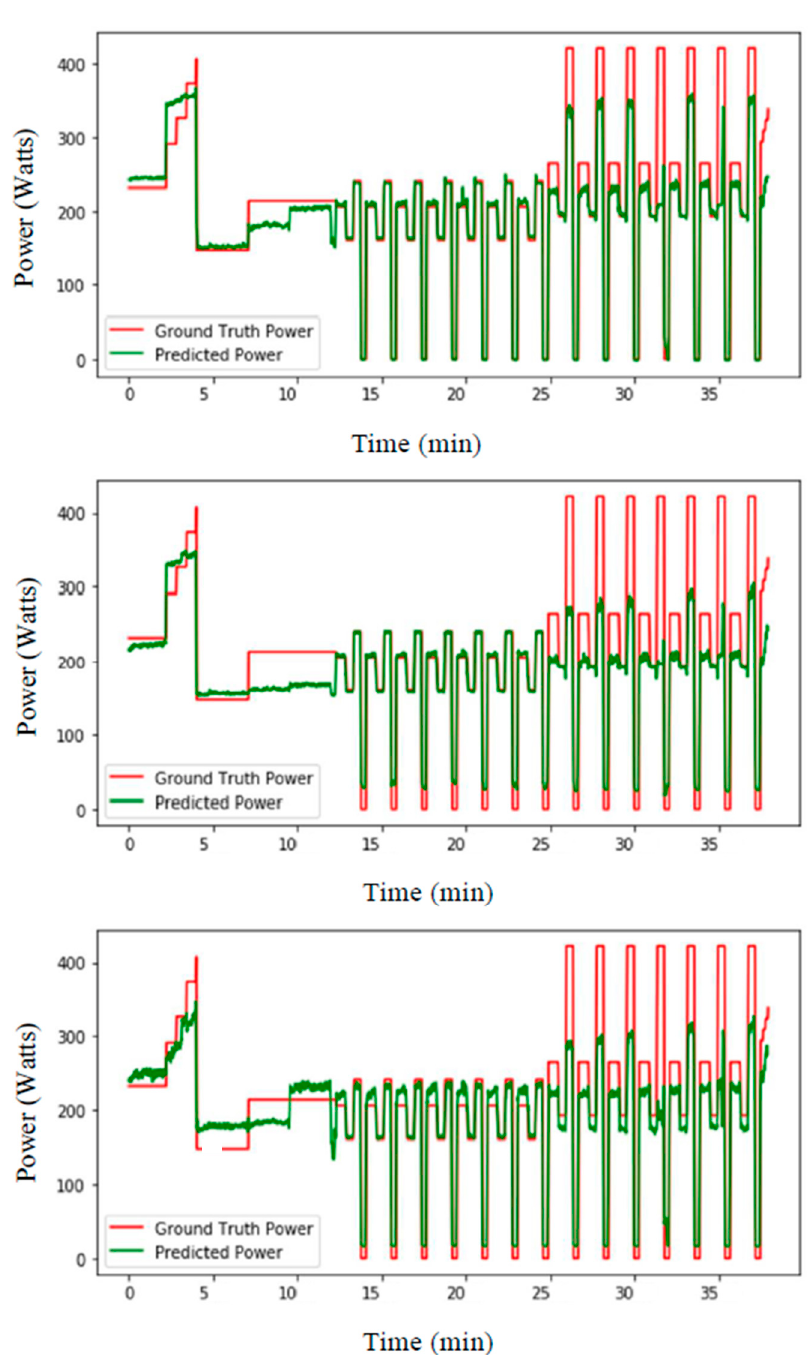
Figure 8. Long Short-Term Memory ( top ), typical large Artificial Neural Network ( middle ), and Convolutional Neural Network ( bottom )-based prediction of ski power (watts) from the data of both days from subject 9, with training data of both days from other subjects.